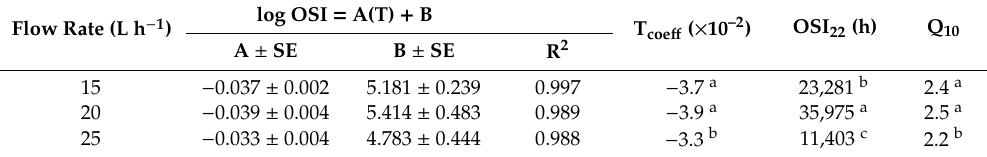
Table 2. Shelf-life prediction, temperature coe ffi cient and Q 10 number calculation. Results from the linear relationship between the logarithms of kernel oxidative stability index (OSI) assessed by Rancimat at 110, 120 and 130 ◦